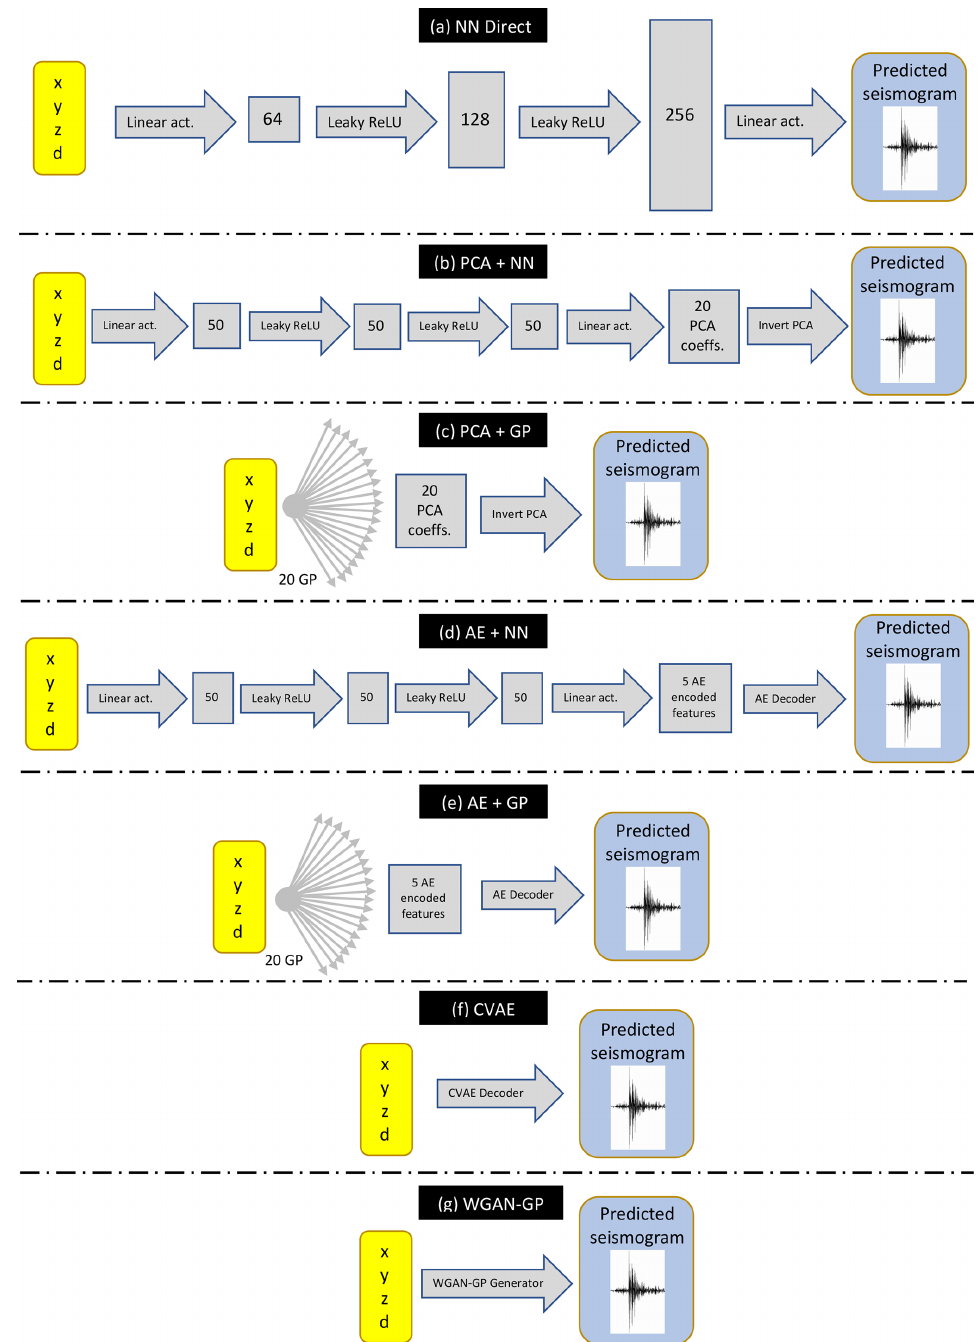
Figure 3. Schematic of the seven proposed algorithms to learn the mapping between coordinates (x,y,z,d) and preprocessed seismograms. A neural network (NN) is used in method (a) , connecting directly source location to preprocessed seismograms. In methods (b) and (c) the preprocessed seismograms of the training set are compressed in principal component analysis (PCA) coefficients, which are then learnt by a NN and Gaussian processes (GPs), respectively. In method (d) and (e) the seismograms are compressed in central features of an autoen- coder (AE), which are then learnt by a NN and a GP, respectively. Finally, a conditional variational autoencoder (CVAE) and Wasserstein generative adversarial networks – gradient penalty (WGAN-GP) are used in method (f) and (g) , respectively, to learn the mapping between source location and preprocessed seismograms. In the schematic, the number of GPs and the architectures of the NNs (including the number of nodes for each layer, represented by blocks of different size, and the linear or non-linear activation functions represented by arrows) are the ones used for the application to the geophysical domain described in Sect.